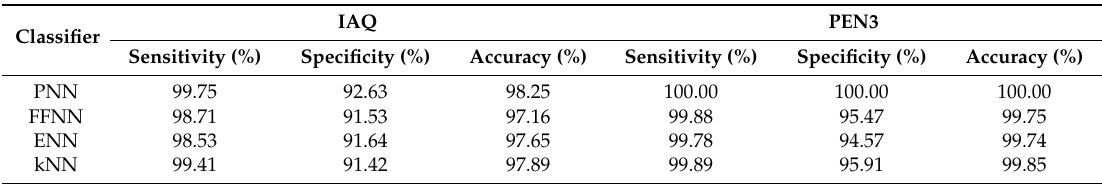
Table 11. Average classification results comparison between different classifiers for proposed PCA based hybrid